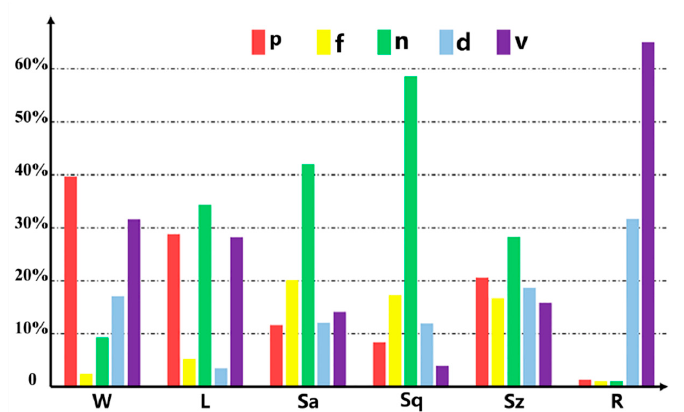
Figure 4. Percentages of contribution from each parameter on cutting characteristics of kerf width ( W ), chipping size ( L ), arithmetical mean roughness ( Sa ), root mean square roughness ( Sq ), maximum roughness ( Sz ), and processing rate ( R ), wherein the red, yellow, green, blue and purple bars correspond to laser-dicing parameters of laser power ( p ), repetition frequency ( f ), number of subpulses ( n ), depth of each pass ( d ), and scanning velocity ( v ),